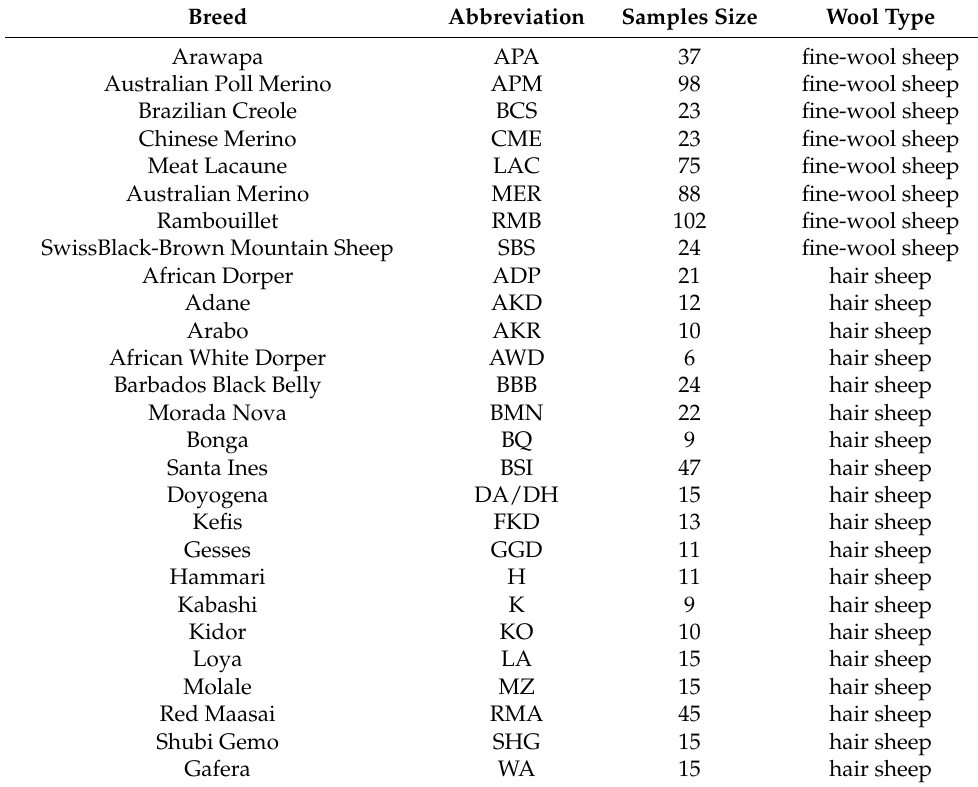
Table 1. Information of the sheep populations used in this